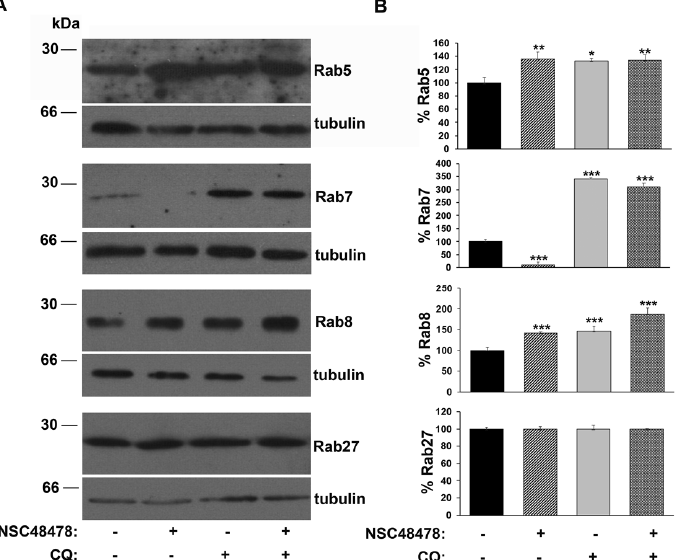
Figure 4. Inhibition of 37/67 kDa LR induces an increase in Rab5/Rab8 and a decrease in Rab7. ( A ) Cells were grown and treated as indicated in Figure 1. Western blotting analysis with the indicated anti-Rab antibodies was followed by anti-tubulin immunodetection, on the same membrane, for control of loading samples. Gels are representative of three independent experiments. ( B ) Data were obtained by imposing as 100% the Rab levels under untreated conditions. To note: no variation in Rab27 levels was detected (* p < 0.05; ** p < 0.01; *** p < 0.001).